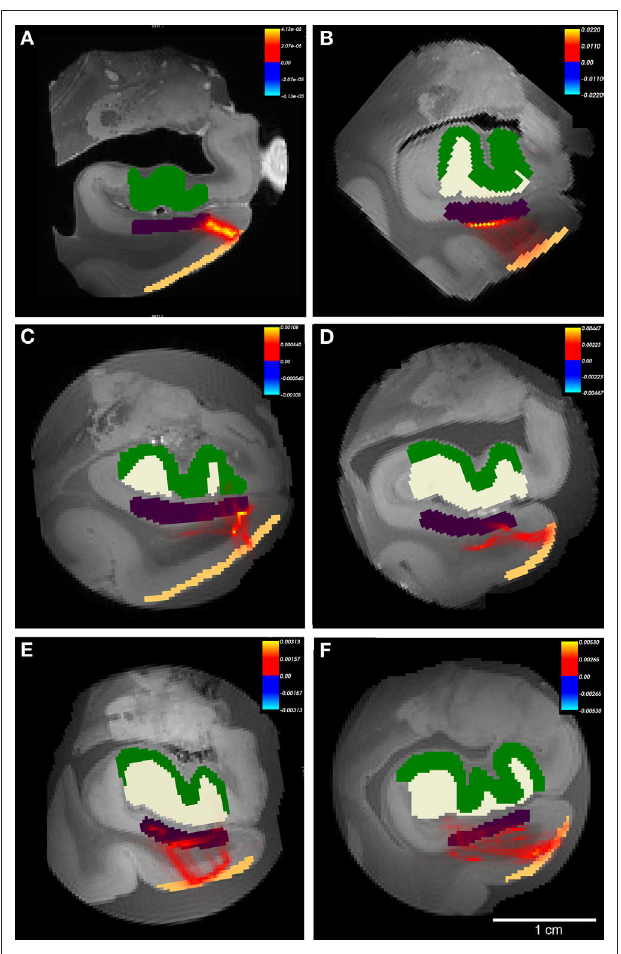
Figure 7 | The probabilistic tractography results between labeled region entorhinal cortex layer ii and subicular cortices (Subiculum+presubiculum) for all cases. In this illustration, probability for hippocampal formation was not tested and labels are shown for reference only. Color labels represent entorhinal layer II (beige), subiculum (purple), dentate gyrus (white) and hippocampus (green). Case A had gadolinium treatment prior to MR scanning and exhibits less noise. All cases showed connections with non-zero probability (A–F) , but cases with higher FA generated higher values than cases with lower FA. Panels (A–F) represent cases 1-6, respectively with Table 1 . Heatmap scalebar located in upper right corner for all cases.